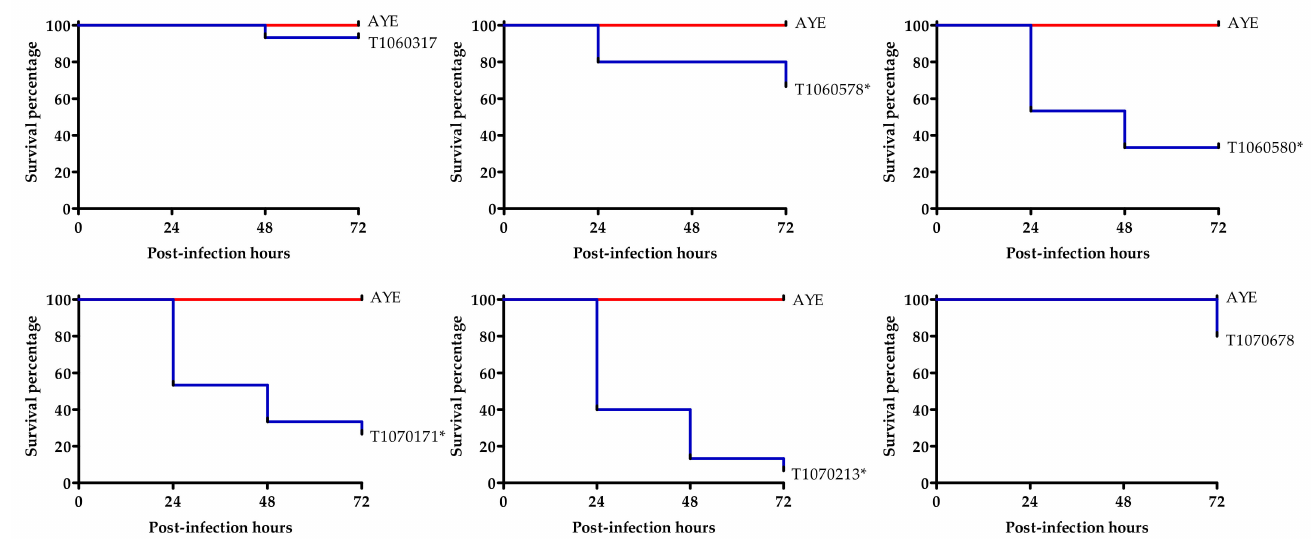
Figure 6. Survival curve of wax moth larvae after injection of the CCR-AB isolates. Fifteen larvae at the late larva stage were injected with 10 5 CFU of each isolate culture. Survival of the injected larvae after 24, 48, and 72 h were scored. The survival curves were plotted using Kaplan–Meier analysis. PBS solution injection (as a negative control) exhibited no lethality during the observation period. A. baumannii AYE was used as a reference for comparison. Representative results from three independent replicates are shown. The asterisks (*) indicate the significant difference ( p < 0.01) between the reference and tested